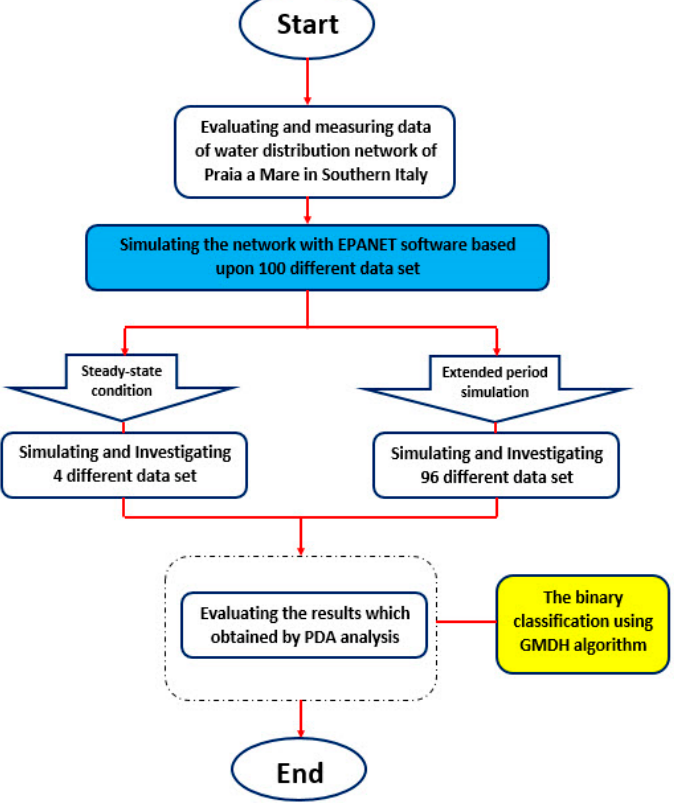
Figure 1. Flowchart of research steps.